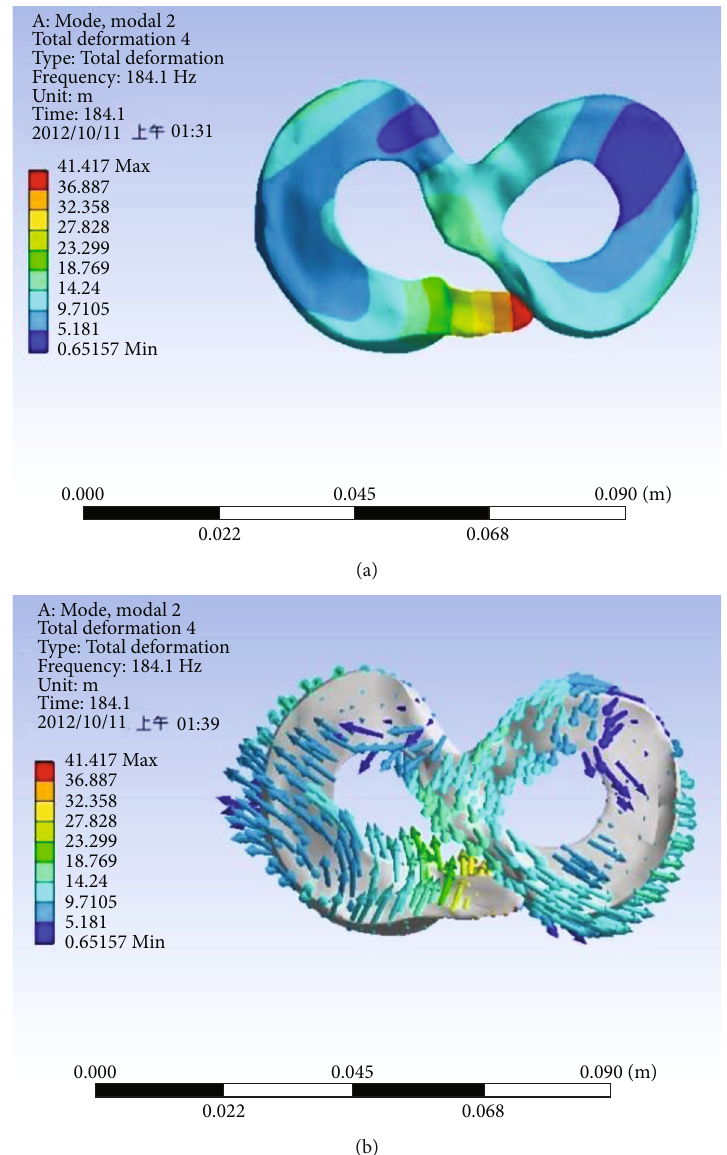
Figure 8: Fourth mode shape of meniscus model at 184.1Hz (bending vibration via thickness direction). (a) Fourth mode shape. (b) Vector plot of fourth mode